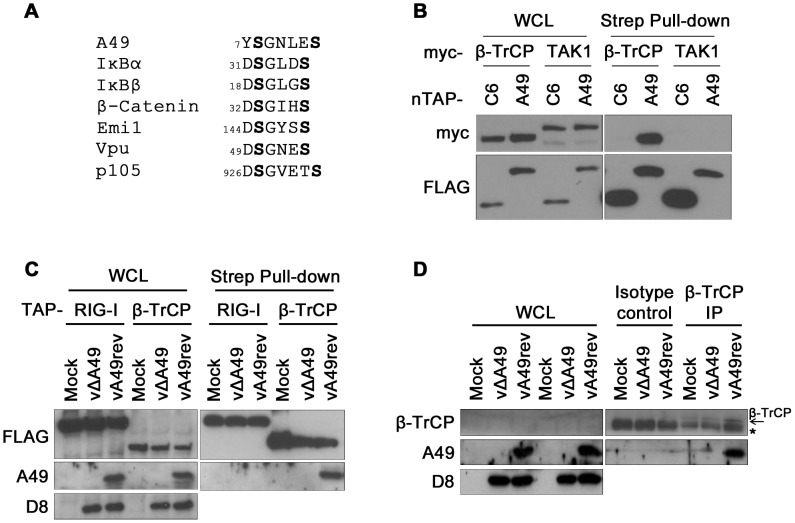
A49 interacts with the ubiquitin E3 ligase β-TrCP.(A) Alignment of β-TrCP recognition motif present in A49, IκBα, IκBβ, β-catenin, Emi1, HIV Vpu and p105. Phosphorylated serine residues are shown in bold and numbers indicate the first residue of the motif in each protein. (B) HeLa cells were cotransfected with myc-β-TrCP or myc-TAK1, with nTAP-A49 or nTAP-C6. Cells were lysed with IP buffer 24 h later and proteins pulled down with streptavidin beads. Whole cell lysate (WCL) (3%) of each sample was analysed. (C) HeLa cells were transfected with TAP-RIG-I or TAP-β-TrCP, and 24 h later were mock-infected or infected with vΔA49 or vA49rev at 10 PFU/cell for 6 h. Cells were lysed in IP buffer and a streptavidin pull-down was performed. D8 immunoblotting served as control for viral infection. WCL (1.5%) of each sample was analysed. (D) HeLa cells were either mock-infected or infected with vΔA49 or vA49rev with 10 PFU/cell for 6 h. After lysis with IP buffer, lysates were immunoprecipitated with a goat anti-β-TrCP antibody or an isotype control. WCL (1%) of each sample was analysed. Asterisk marks the antibody heavy chain. Data shown in (B) and (C) are one representative experiment of at least three. Data shown in (D) are one representative experiment out of two showing indistinguishable results.